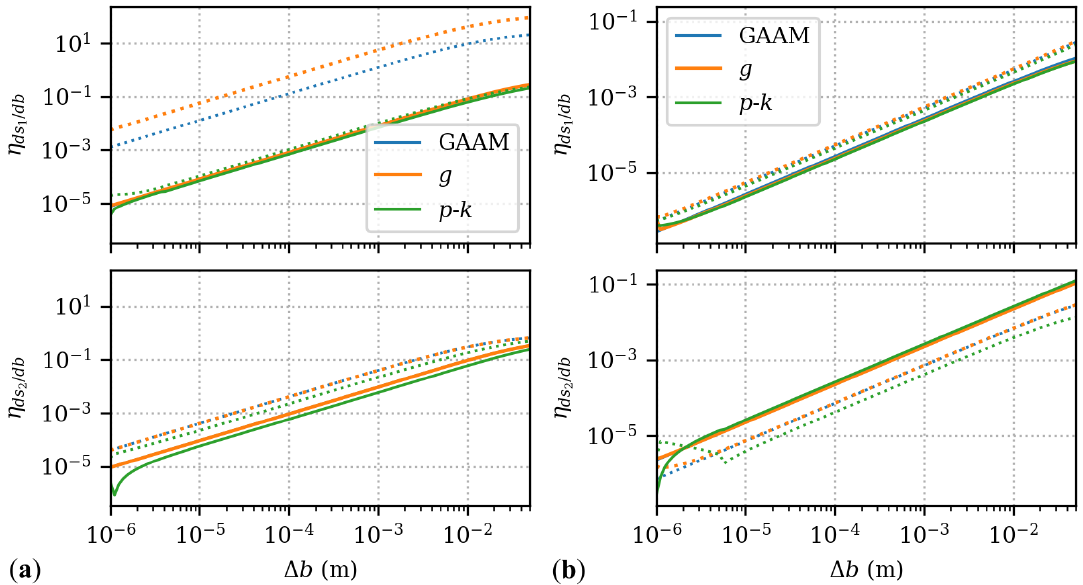
Figure 4. Relative errors of the eigenvalue derivatives for the typical section model over ∆ b dis- playing linear convergence in the real (solid) and imaginary parts (dotted). ( a ) V = 209.6 m/s. ( b ) V = 241.2 m/s.